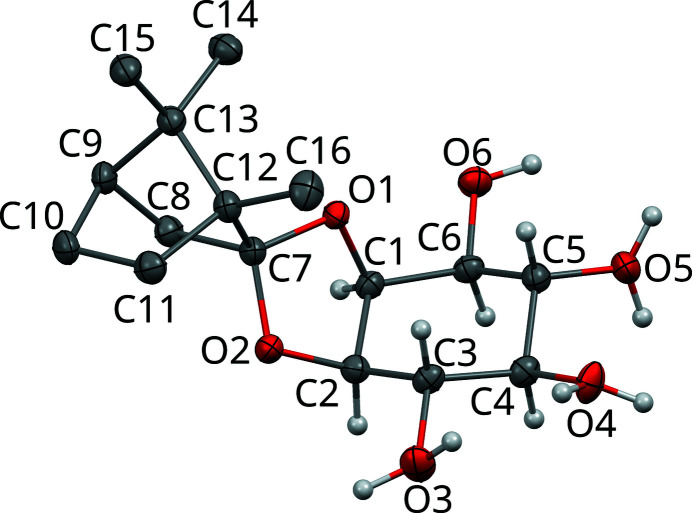
Molecule of 1 in the basic structure with atom-labeling scheme. C (gray) and O (red) atoms are represented by ellipsoids drawn at the 50% probability level, H atoms by spheres of arbitrary radius. H atoms of the bornane moiety are omitted for clarity. For disordered hydroxyl groups (O3, O4, O5), both orientations of the H atoms are shown.